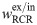
Mixed feedback has different effect on low and high frequency components of natural scenes in contrast to pure excitatory or inhibitory feedback.Each subfigure shows activation of a layer of relay cells in response to the input image, shown as a logarithmic color map from blue to red (from reduced to increased response). the responses are normalized with respect to the maximum response in the case without cortical feedback. The red and blue circles mark representative parts of the image with high and low spatial frequency, respectively. Default values from Table 1 have been used except for the feedback weights wRCRex/in which have been set at 1.8 times the listed default values to more clearly demonstrate qualitative effects.